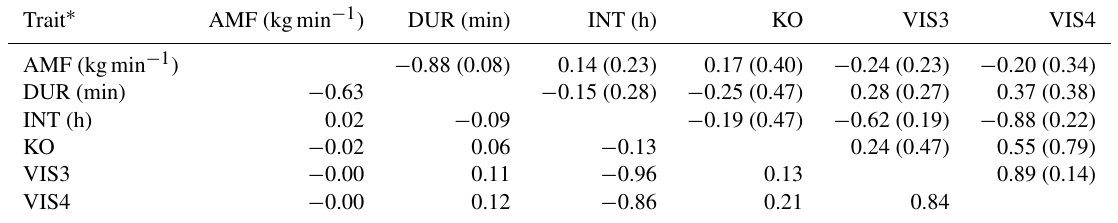
Table 5. Genetic correlations among behavior indicator traits (above the diagonal with standard errors in brackets) and corresponding correlations among breeding values from bulls with at least five daughters (below the diagonal).